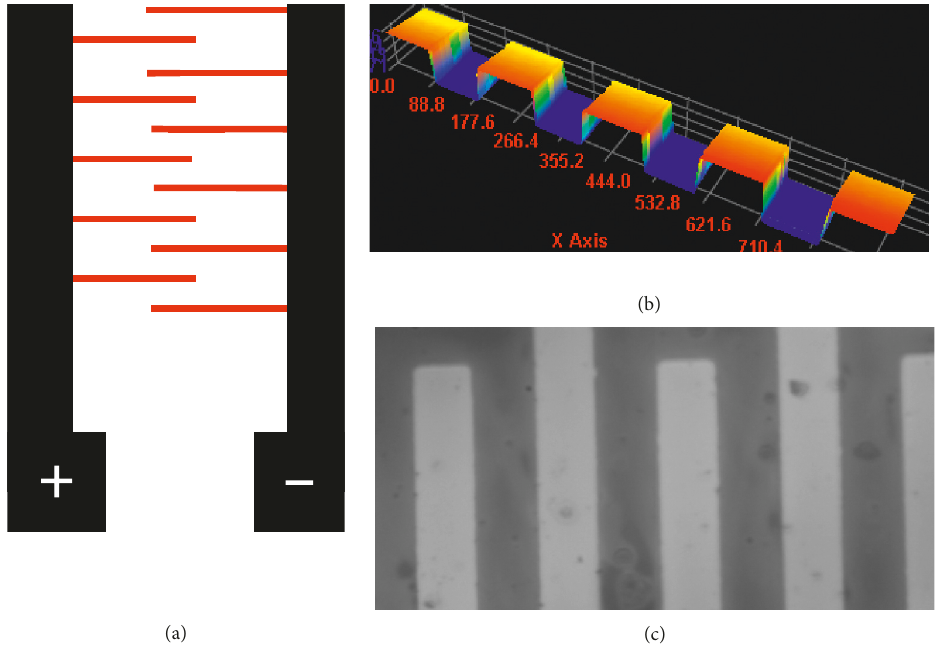
Figure 2: Surface analysis of the IDE. (a) Diagram representation of the dielectric sensor. Both positive and negative electrodes are shown with the finger regions. (b) The surface of the IDE sensor gap regions is displayed by a 3D nanoprofiler. (c) The surface of IDE sensor gap regions is displayed by high-power